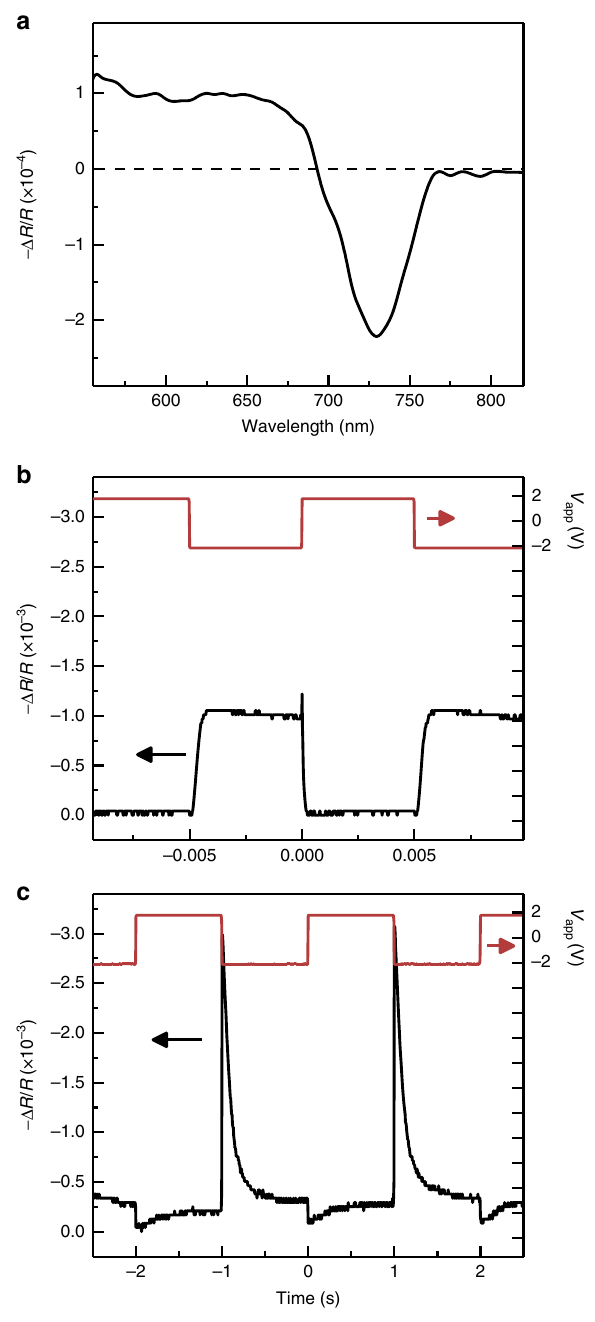
Fig. 5 Electroabsorption probe of internal electric fi eld. a Electroabsorption (EA) spectrum acquired in differential re fl ectivity from a device depleted in reverse bias at − 2 V with a 0.8 V peak-to-peak sinusoidal dither at a modulation frequency of 389 Hz. b Transient EA signal resulting from a − 2 to 2 V square wave signal with a 10 ms period. c Increasing the square wave period to 2 s leads to a decay of the EA signal during each half cycle that indicates screening of the internal electric fi eld in the perovskite as a shift in recombination zone discussed below, it agrees with fi nite element thermal modeling shown in Fig. 6d. There, the onset of non-negligible Joule heating occurs at J ~10 A cm − 2 for 2 μ s pulses and the transient temperature rise of the perovskite layer shown in the inset mirrors the functional form of the EL intensity decay reproduced from Fig. 6b, supporting the connection between the two.